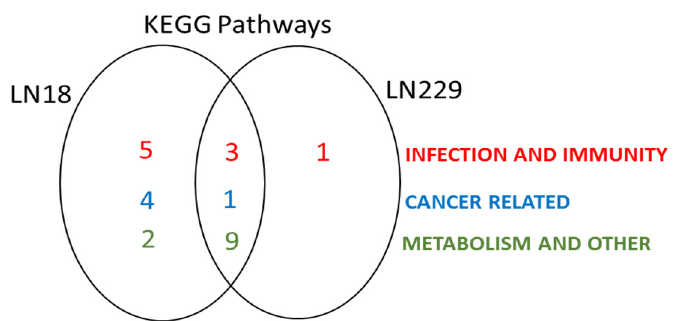
Figure 9. Deiminated Kyoto Encyclopedia of Genes and Genomes (KEGG) protein networks differ between LN18 and LN229 GBM cells. A Venn-diagram representing shared and different KEGG pathways identified to be enriched in deiminated proteins in the two GBM cell lines under study (LN18 and LN229), under standard culture conditions. For detailed network analysis highlighting the different KEGG pathways in both cell lines see Supplementary Figures S3,S4.